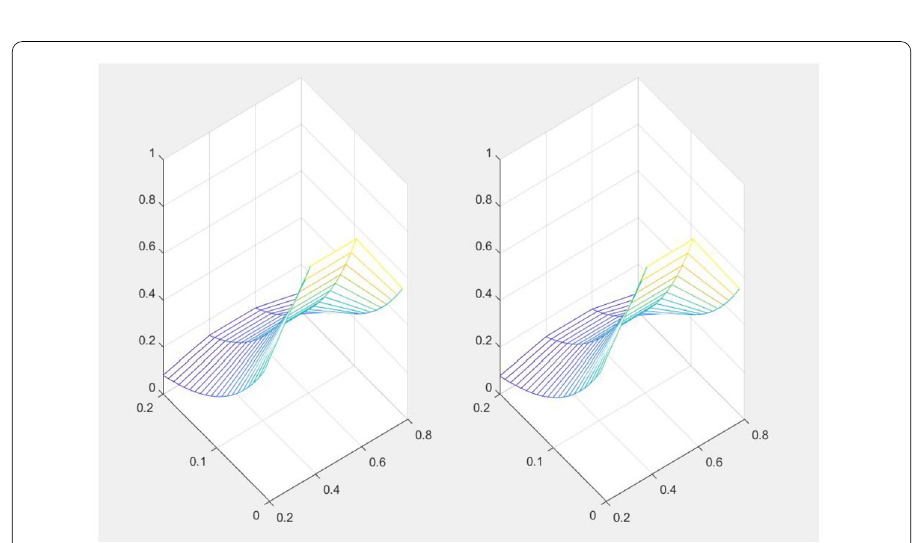
Figure 5 The 3D-plot of the analytical solution (left) and the numerical solution (right) for Example